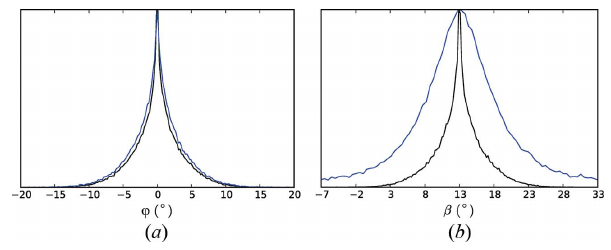
Figure 15 Simulation of the determination of ’ and (cid:2) . ( a ) Distributions of the true values of ’ (black) and the estimated values ^ ’’ (blue). ( b ) Distributions of the true values of (cid:2) (black) and the estimated values ^ (cid:2)(cid:2) (blue).